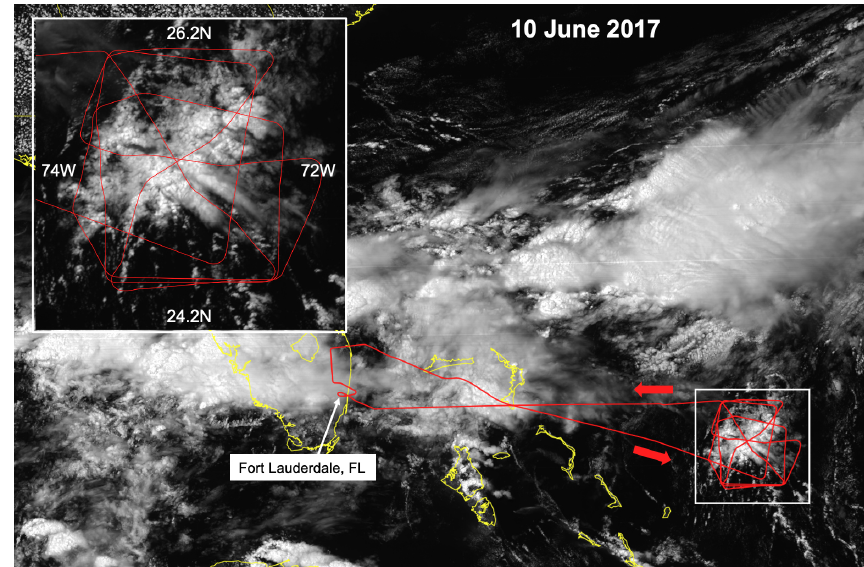
Figure 2. The 10 June 2017 flight track (red lines) shown on the JPL CPEX data portal. The DC-8 home base at Fort Lauderdale, FL, is indicated. The main area of interest is shown in the expanded box, covered by the DC-8 during the 18:30–22:30UTC time period. The grayscale background depicts the GOES-16 visible imagery at 19:02UTC.